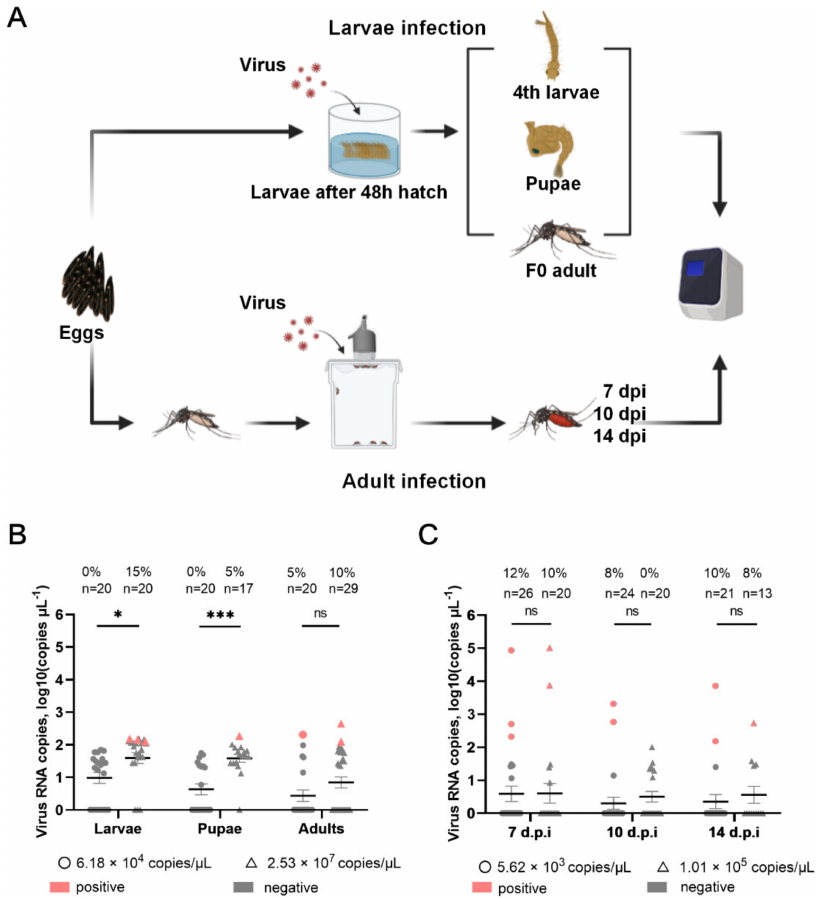
Figure 5. The result of mosquito infection through oral infection. ( A ) The process of mosquito infection was divided into larvae infection through feeding in water and adult infection through